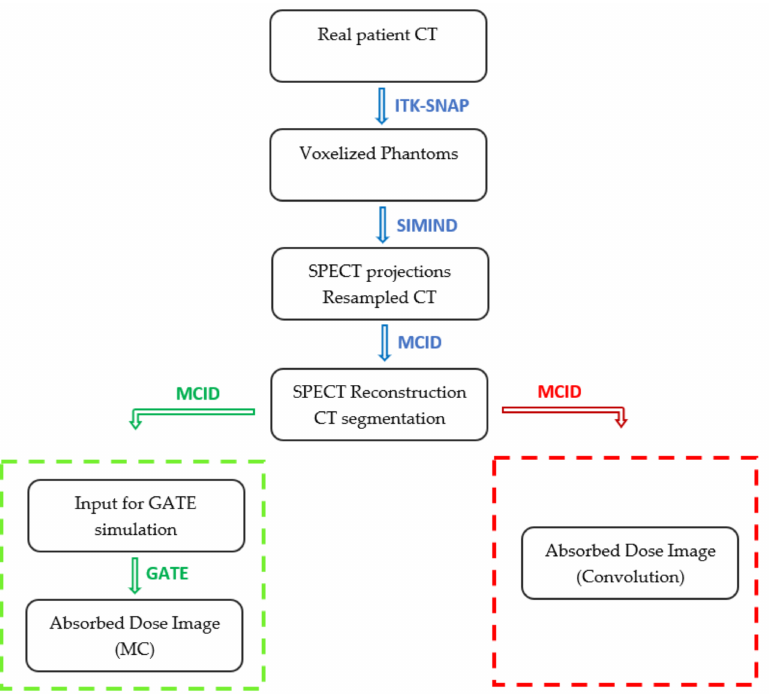
Figure 4. Schematic representation of the workflow and software packages used in this study. The blue steps are specific for the validation with the computational phantoms and they will not be performed (except for the CT segmentation) when dealing with real patient images. The latter should be directly imported into the MCID